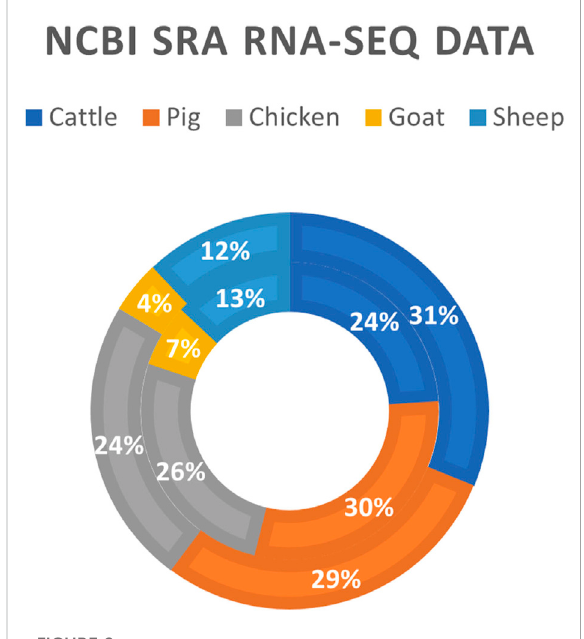
FIGURE 2 Livestock RNA-Seq datasets in NCBI SRA database. Data was generated using the online “ Run Selector ” tool on the NCBI SRA website (https://www.ncbi.nlm.nih.gov/sra; accessed 12 August 2022).Theouterringrepresentsthenumberofbiosamplesin the database ( N = 59,634), and the inner ring represents the number of distinct bioprojects in the database ( N =